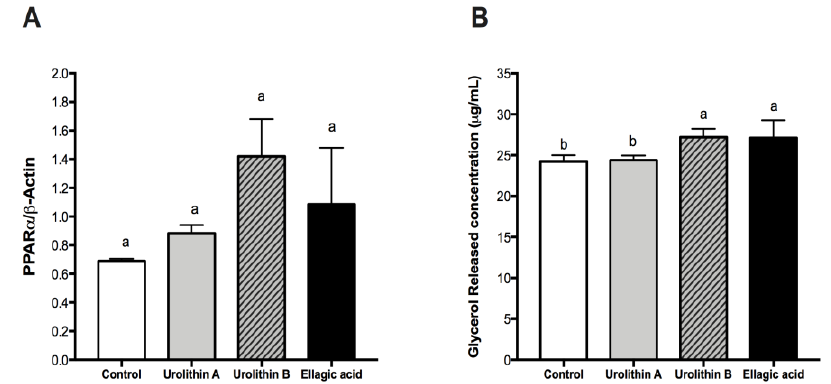
Figure 5. Effect of ellagic acid, urolithin A, and urolithin B in the protein expression of peroxisome proliferator-activated receptor-α (PPARα) ( A ) and measurement of glycerol released into the culture medium of 3T3-L1 adipocytes ( B ). The protein expression of PPARα was determine by Western blot after 8 days of treatment with 25 µM of the compounds, as described in the Materials and Methods section. The values represent the mean ± SD ( n = 3) of three independent experiments. (B) Shows the concentration of glycerol released into the culture medium determined by spectrophotometry at 540 nm. Different letters among bars denote significant changes among treatments and control ( p ≤ 0.05) performed by ANOVA and Tukey’s post hoc